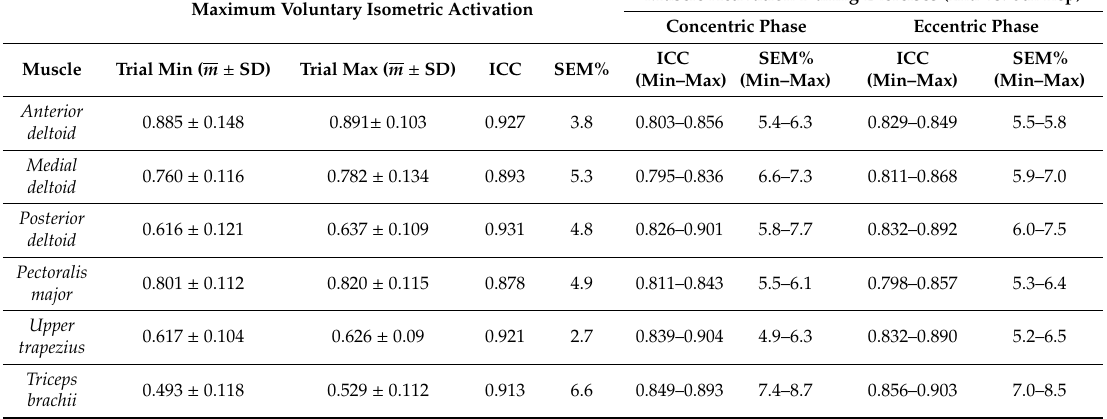
Table 1. Intrasession reliability (ICC and SEM%) of surface electromyography root mean square value calculated during the maximum voluntary isometric test and during the concentric and eccentric phase of each